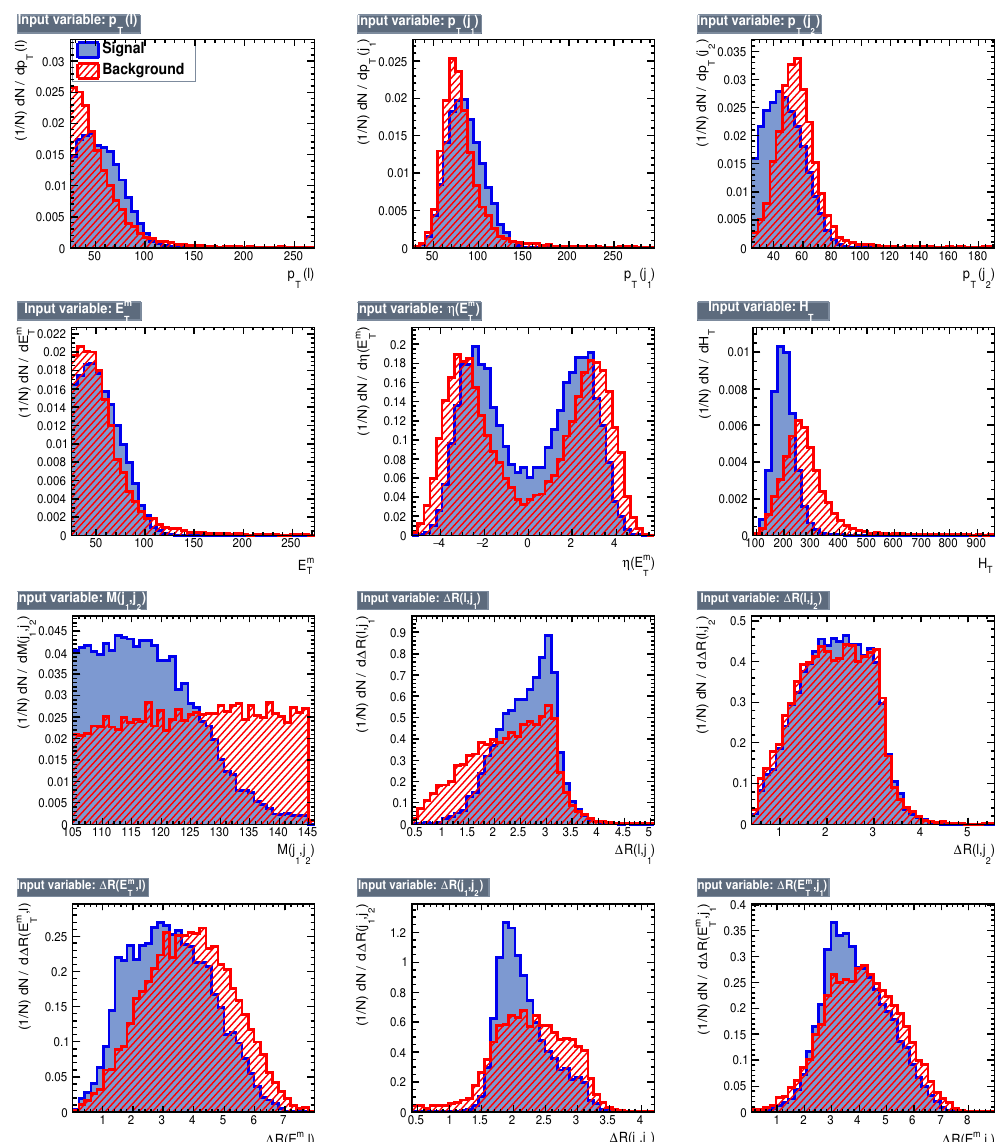
Figure 2 . Normalized distributions of the input variables at the LHC ( p s = 13 TeV) used in the MVA for the signal (blue) and the background (red). Signal distributions are obtained for m 300 GeV, and the background includes all the dominant backgrounds discussed in subsection